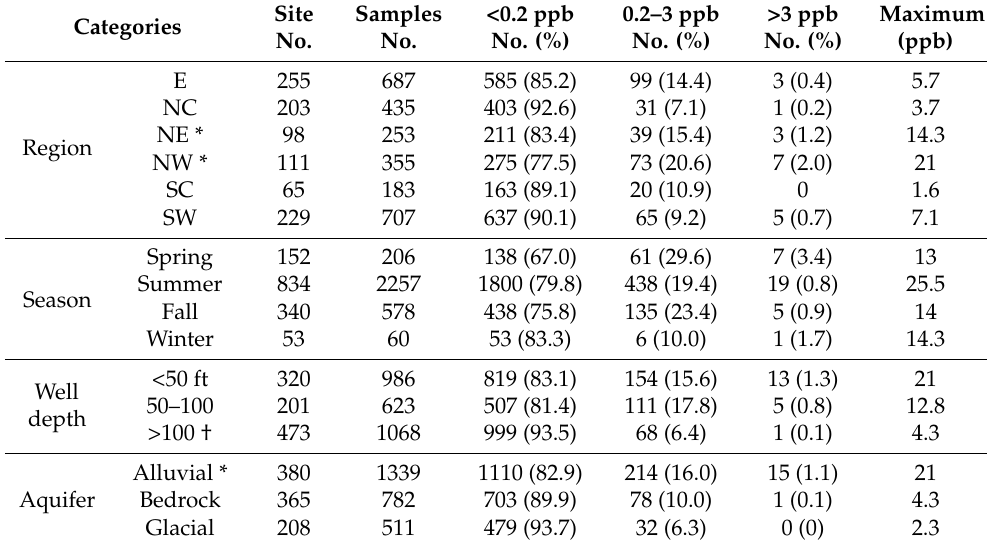
Table 5. Occurrence of Atrazine in Public Wells (Drinking Water MCL = 3 ppb).